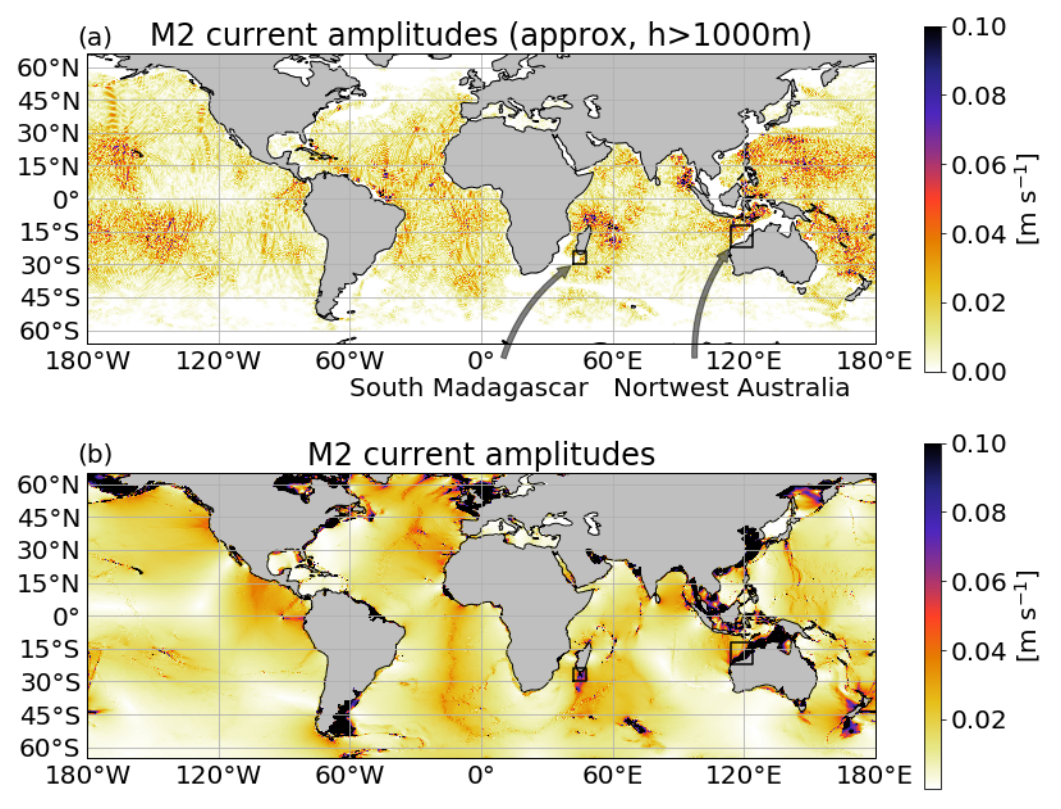
Figure 1. ( a ) HRET M2 baroclinic current amplitude for regions with bathymetry(h) deeper than 1000 m ( b ) FES2014 M2 barotropic current amplitude. The colormap is saturated at 10 cm/s on both figures. Two black boxes delimit the regions of the case study presented in Sections 4.1 and 4.2,